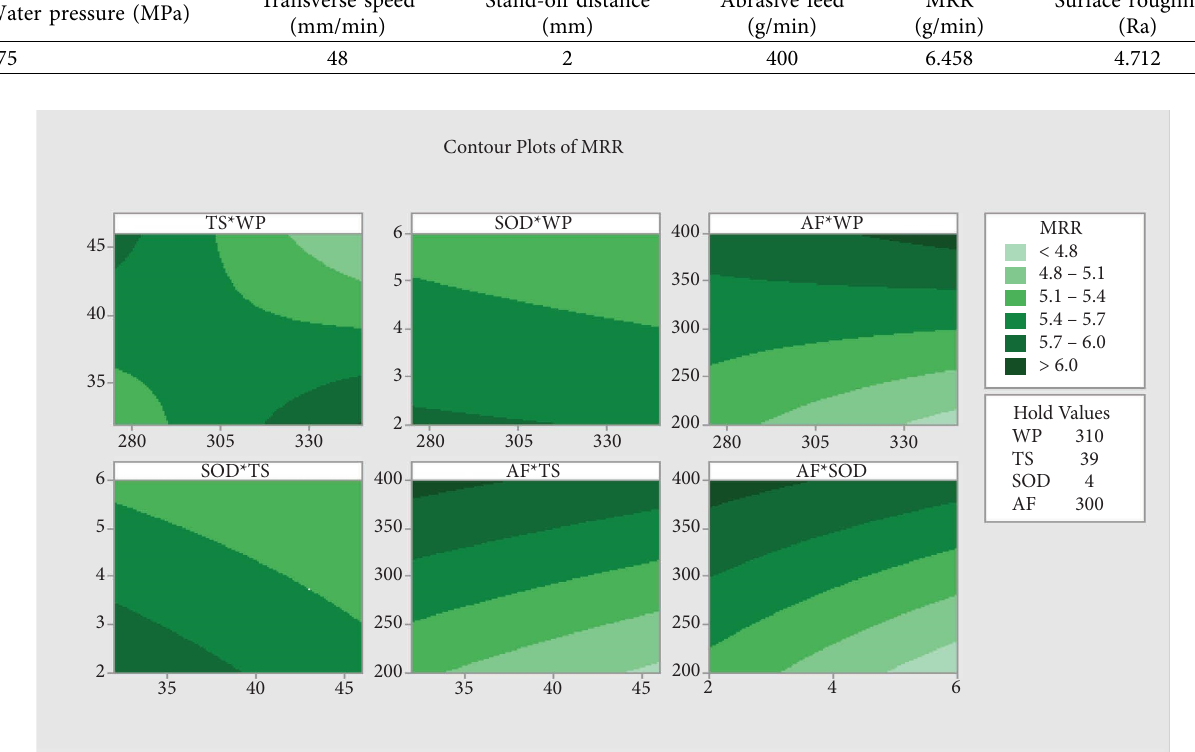
Figure 1: Contour interactions for metal removal rate.